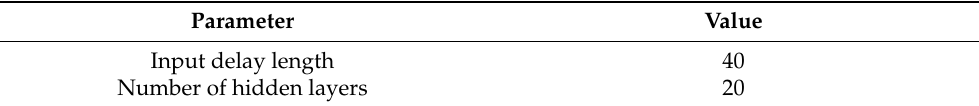
Table 5. Network static configuration parameters (when evaluating the impact of the time division). Parameter Value Input delay length 40 Number of hidden layers 20